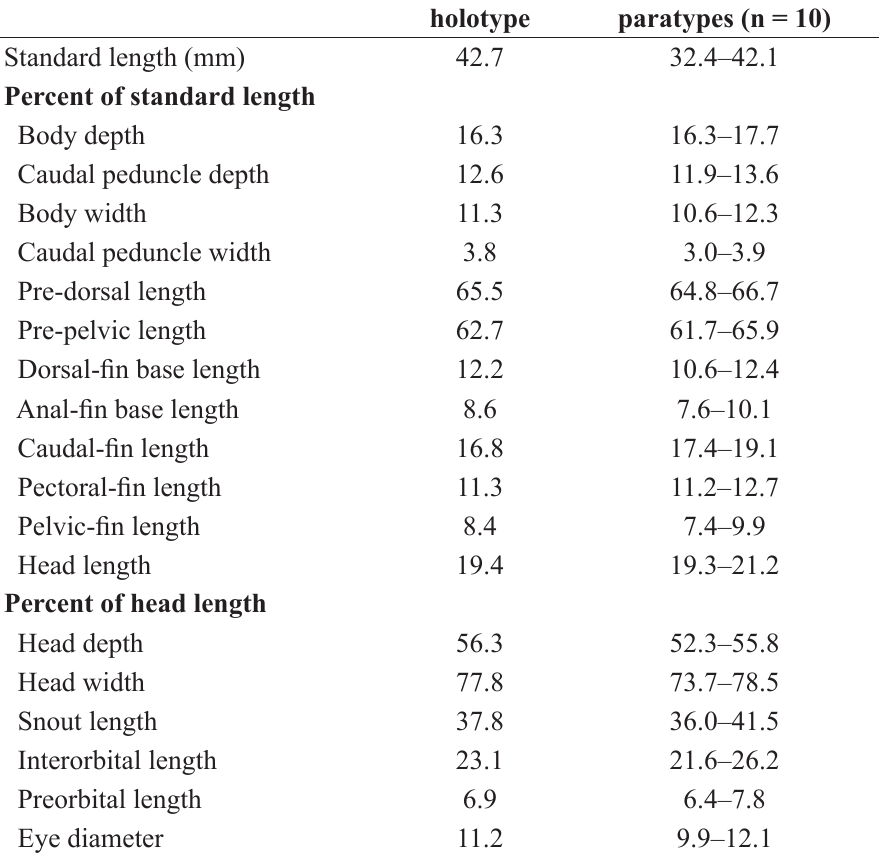
Table 2. Morphometric data for Cambeva betabelardense sp.